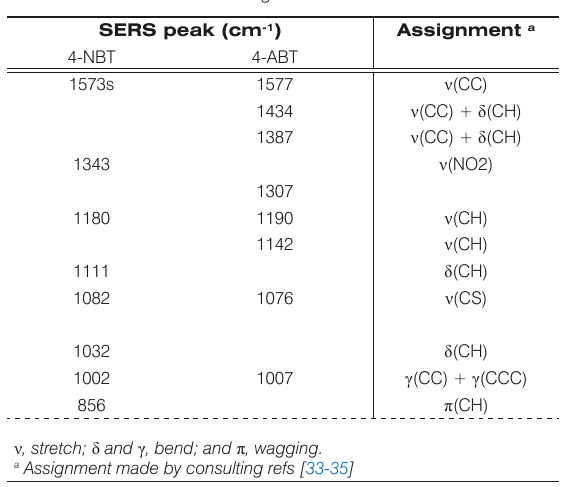
Table 1. SERS peak assignment of 4-NBT and 4-ABT on nanostructured gold substrates.